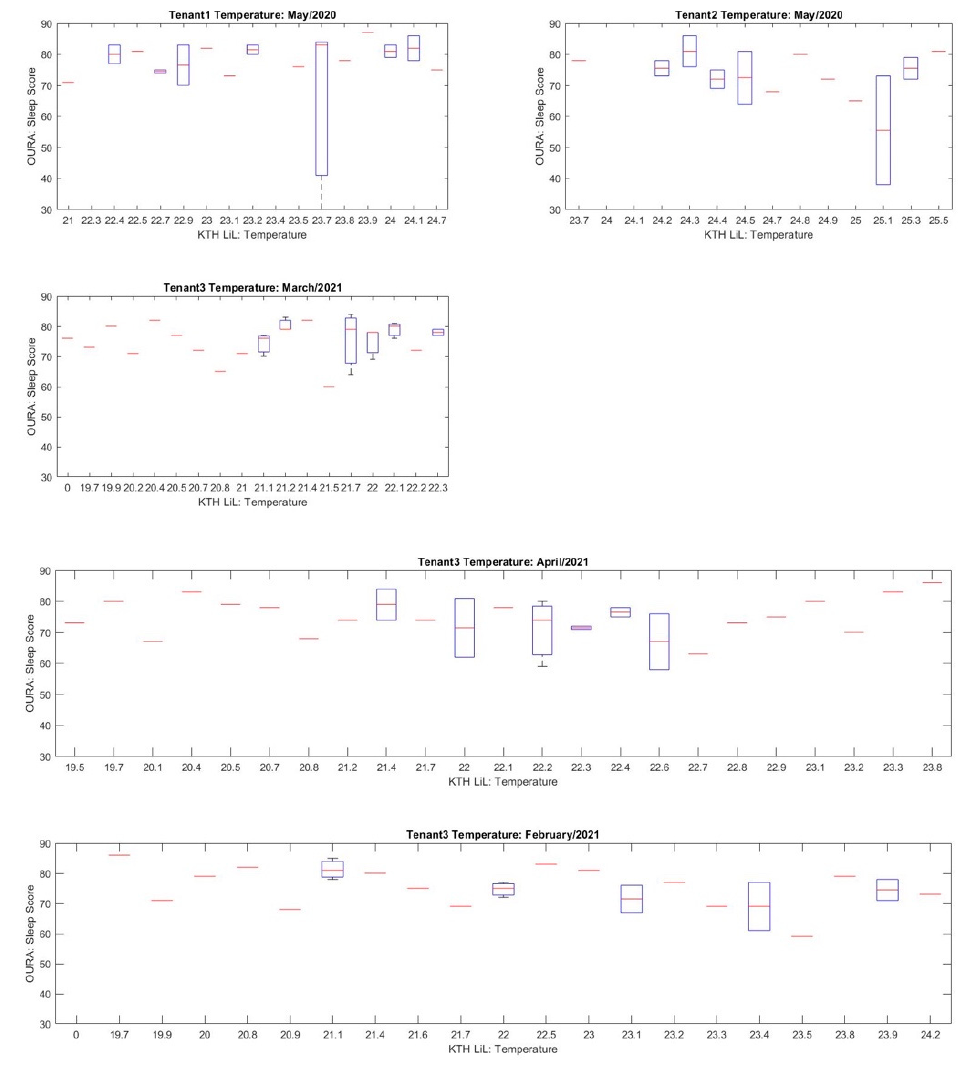
Figure 10. Sleep score vs.